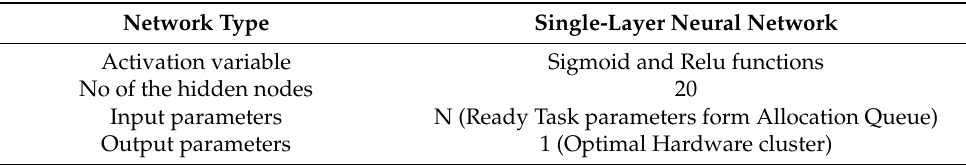
Table 3. SLFN resource Predictor testing parameters.